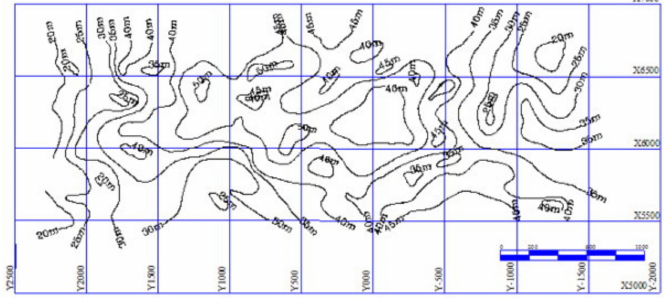
Figure 1. Typical isoline showing marine clay’s total thickness